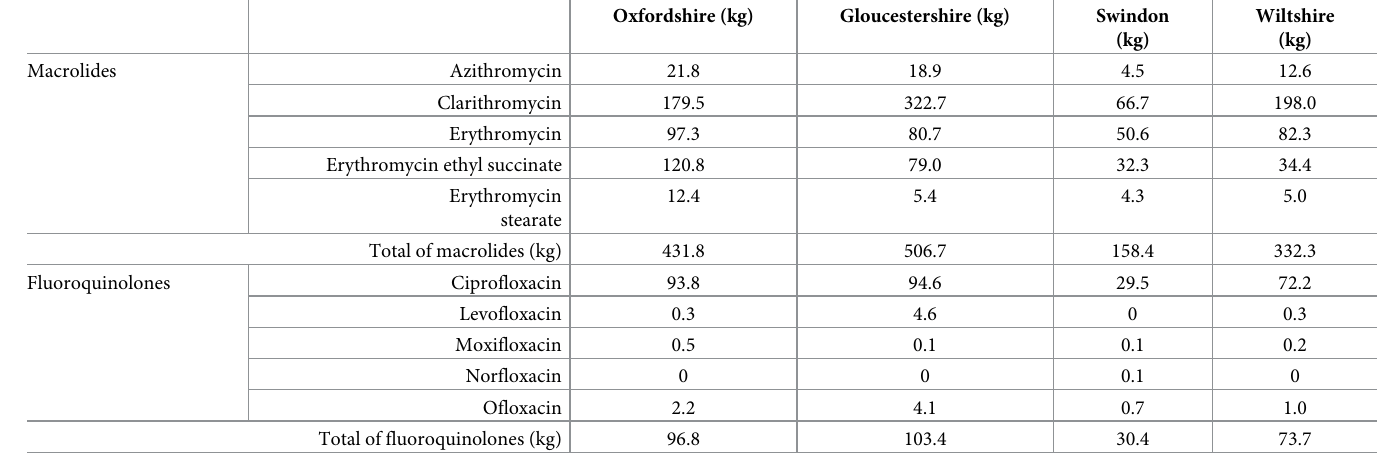
Table 1. Mass of macrolides and fluoroquinolones prescribed in the study CCGs in 2015/16.